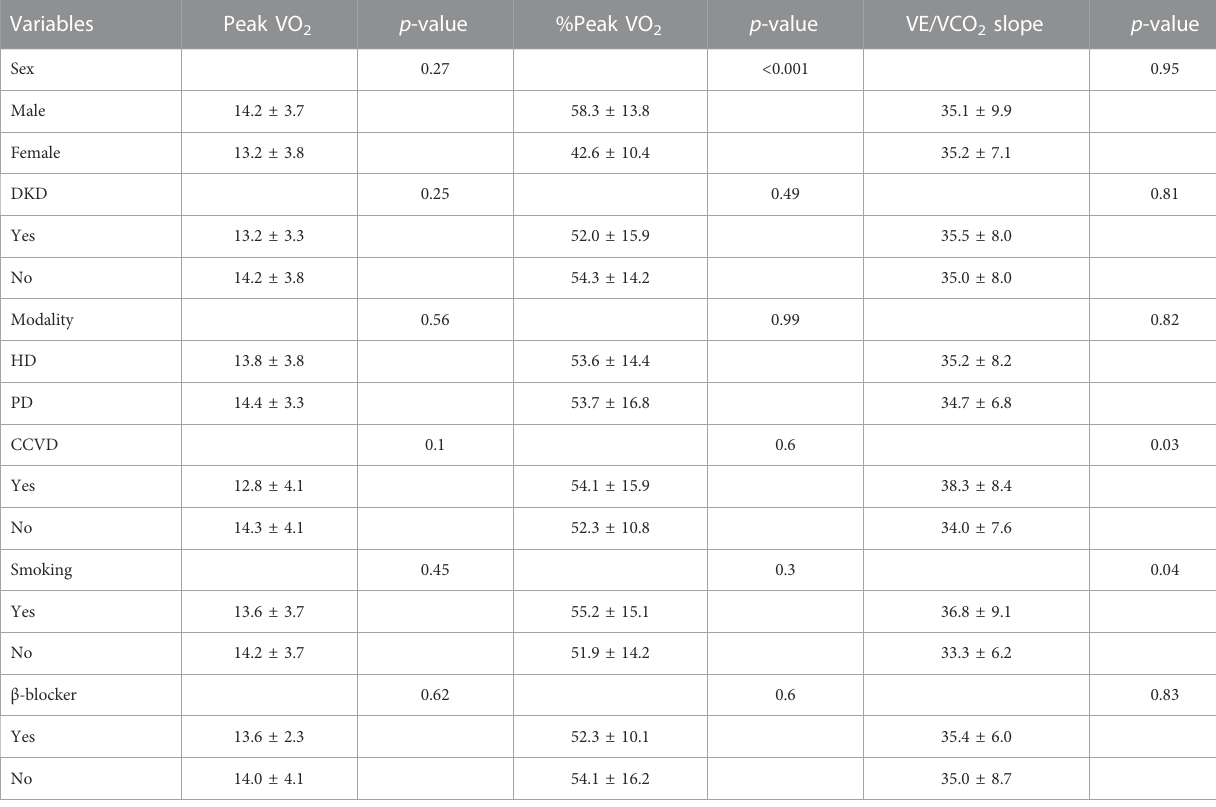
TABLE 2 Comparisons of primary outcomes between